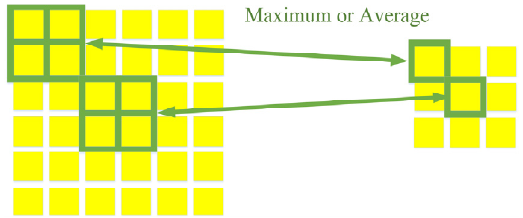
Figure 3. Schematic diagram of pooling